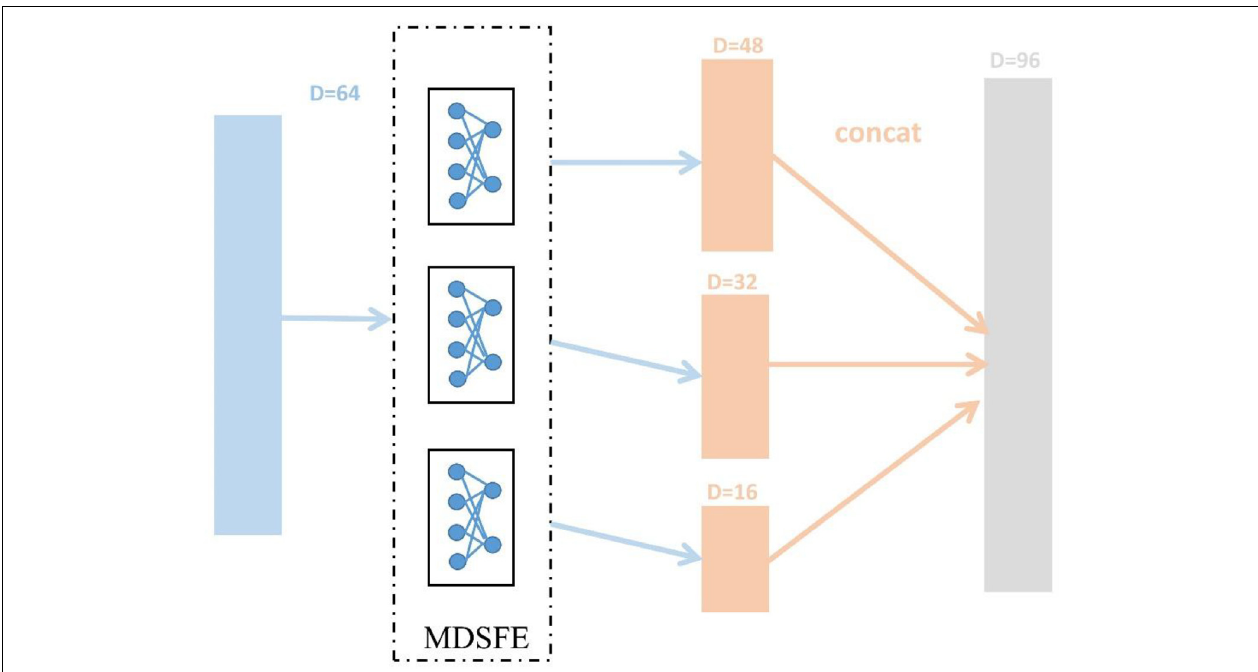
FIGURE 4 | Extract 48-dimensional, 32-dimensional, and 16-dimensional high-level feature representations process from 64-dimensional low-level features, respectively.